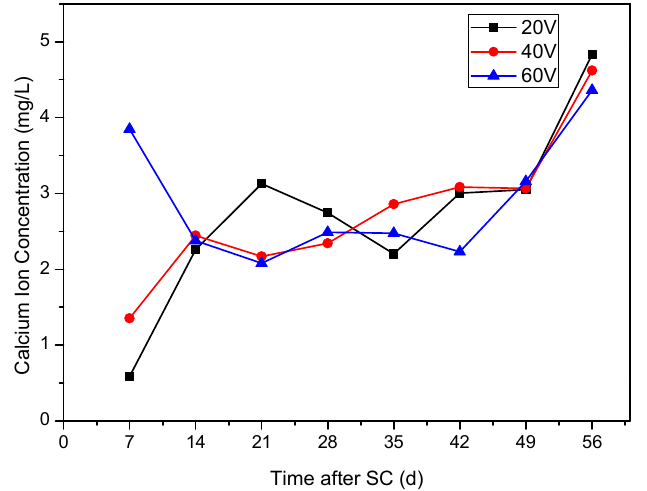
Figure 7. Ca 2+ concentration in solution under different stray currents (Mix ratio of No.2 in Table 6). After 49 d, the concentration of Ca 2+ increases significantly, which may be because the Ca 2+ supplied by C–H crystal inside the specimen is consumed. In order to maintain the internal charge balance of the specimen, the C–S–H gel is decomposed successively, and abundant Ca 2+ in the specimen leads to the peak of Ca 2+ dissolution and increase of calcium concentration in the